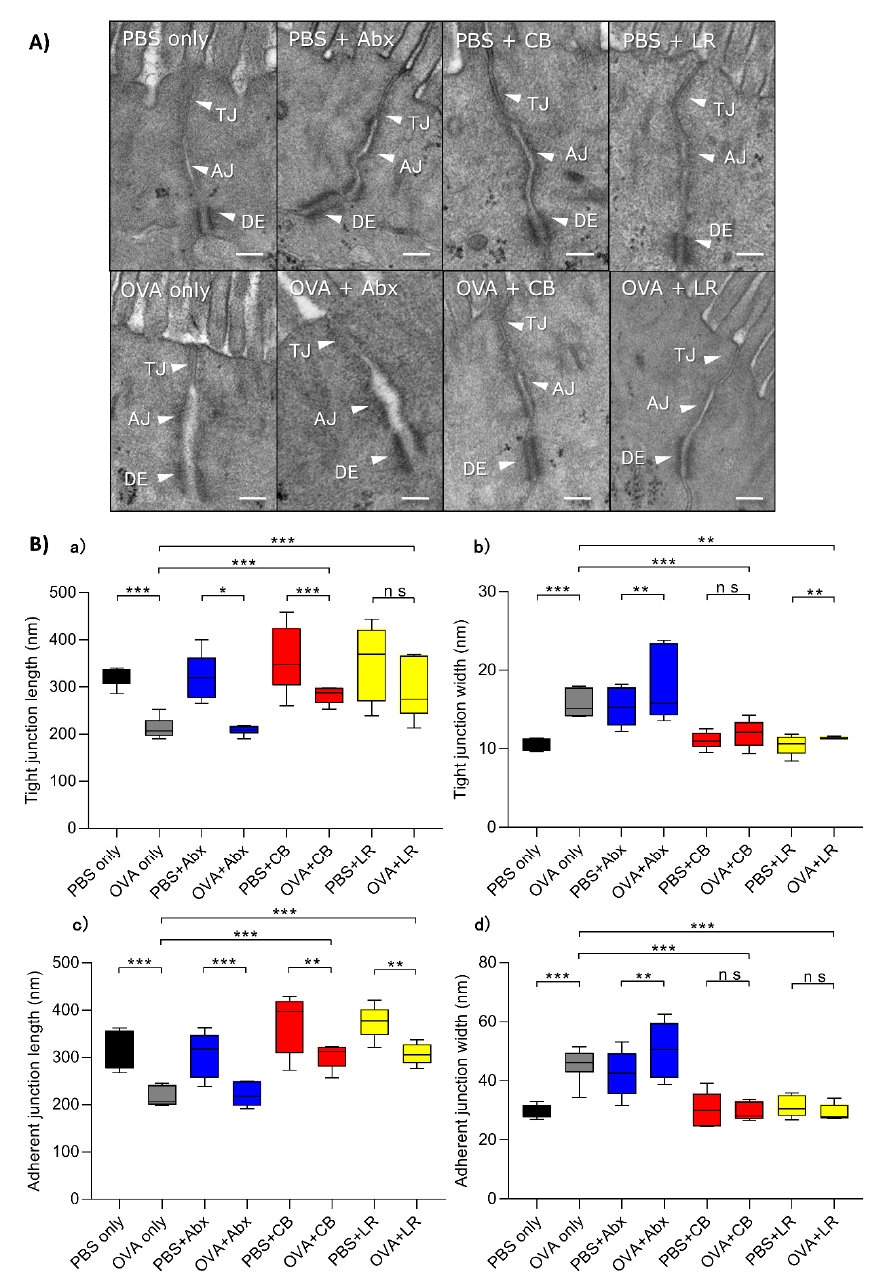
Figure 4. ( A ) Electron microscopy images of epithelial cells. Scale bar indicates 0.5 µ m. TJ, tight junction; AJ, adherens junction; DE, desmosome. ( B ) ( a ) Quantitative analysis of TJ length. ( b ) Quantitative analysis of TJ width. ( c ) Quantitative analysis of adherens junction length. ( d ) Quantitative analysis of adherens junction width. Boxes represent the 25th to 75th percentiles; middle bar identifies the median; whiskers show the minimum and maximum ( n = 5–7 rats per group). * p < 0.05, ** p < 0.01, *** p < 0.001 determined by ANOVA with the Tukey–Kramer method. ns, no significance; Abx, antibiotics; CB, C. butyricum ; LR, L.